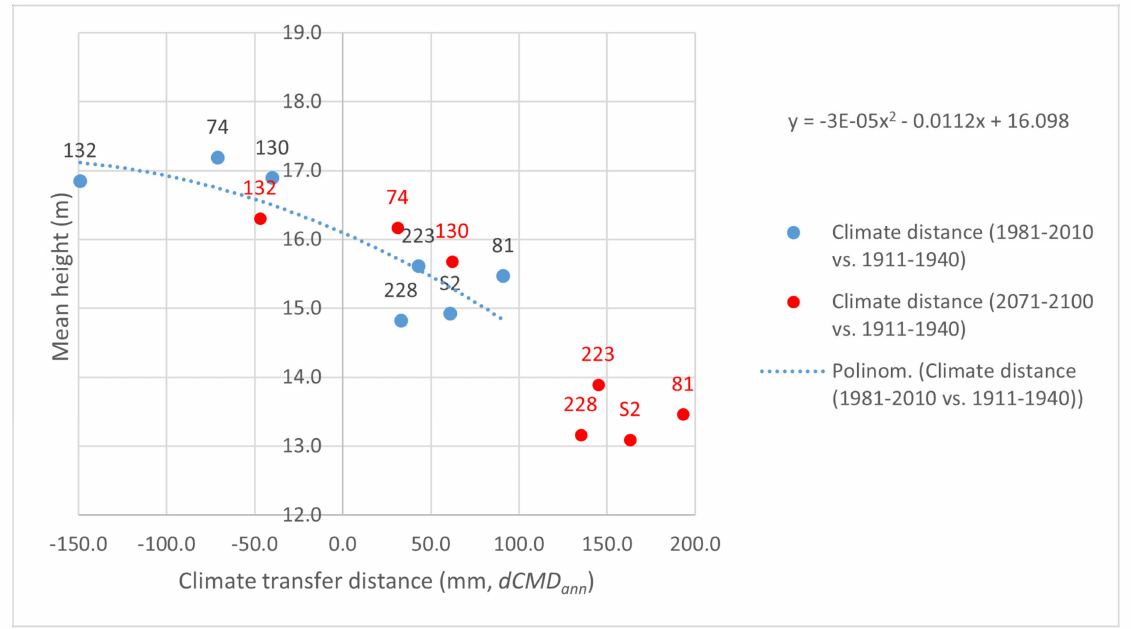
Figure 4. Current and the future climatic transfer distance and mean height response of silver fir provenances in the P í sektrial. Their performance is compared under two transfer situations, current heights at the test site (data measured in 2015, blue dots) and projected heights (climate period 2071–2100, derived from ClimateEU , pathway RCP8.5, red dots). The transfer equation for current vs past climate was extrapolated for future data. The horizontal axis shows climate transfer distances (precipitation mm deficit). For the sake of comparison, current and future heights are both presented as the site index value for the age of 40 years, i.e., in